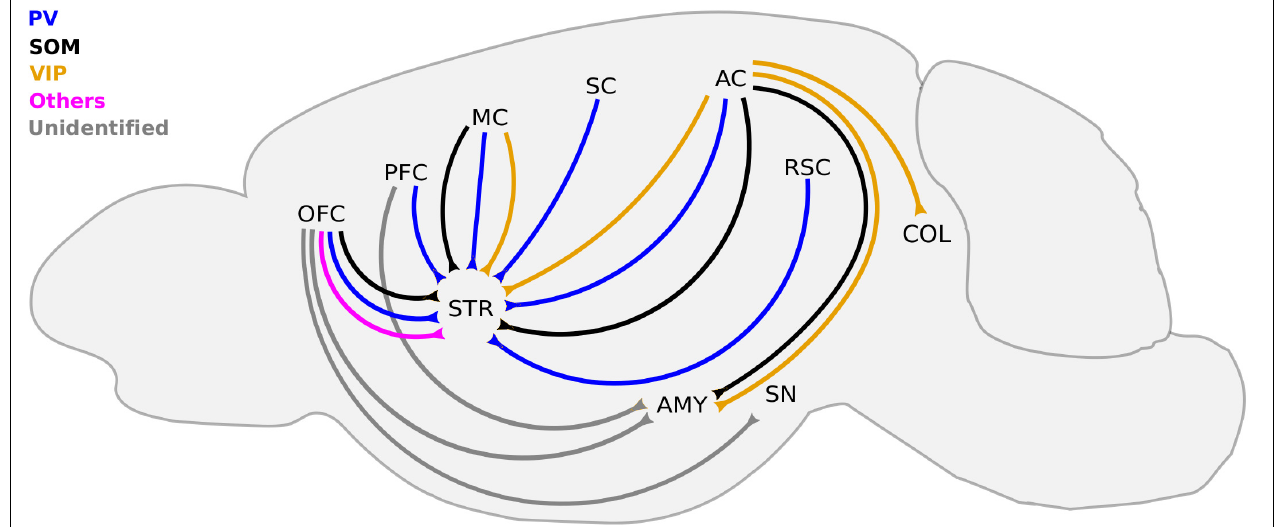
FIGURE 2 | Known cortico-fugal LRGNs. LRGNs in the neocortex project to a variety subcortical areas, some of which are not included here. For simplicity, we highlight those that have been functionally characterized or investigated in more detail. Corticofugal LRGNs are diverse in their molecular markers. The PFC sends PV-LRGN projections to the STR, and the molecular identity of LRGNs to the AMY remains unidentified. SOM+, PV+, and other LRGNs (magenta) in the OFC send axons to the STR, and those that project to the AMY and SN are unidentified (gray). SOM+, PV+, and VIP+ axons to the STR arise from the MC and AC, which also sends SOM+ and VIP+ projections to the AMY and COL. The SC and RSC contain PV-LRGNs that project to the STR. AC, auditory cortex; AMY, amygdala; COL, colliculus; MC, motor cortex; OFC, orbitofrontal cortex; PFC, prefrontal cortex; RSC, retrosplenial cortex; SC, somatosensory cortex; SN, substantia nigra, STR, striatum; PV, parvalbumin; SOM, somatostatin, and VIP, vasoactive intestinal